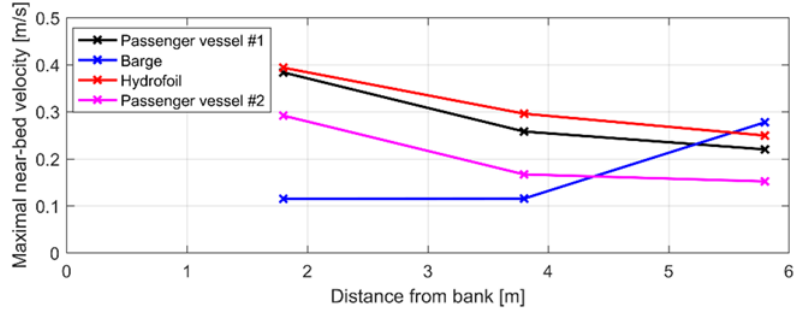
Figure 8. Maximal near bed velocities measured for different ships in different distances from the bank.